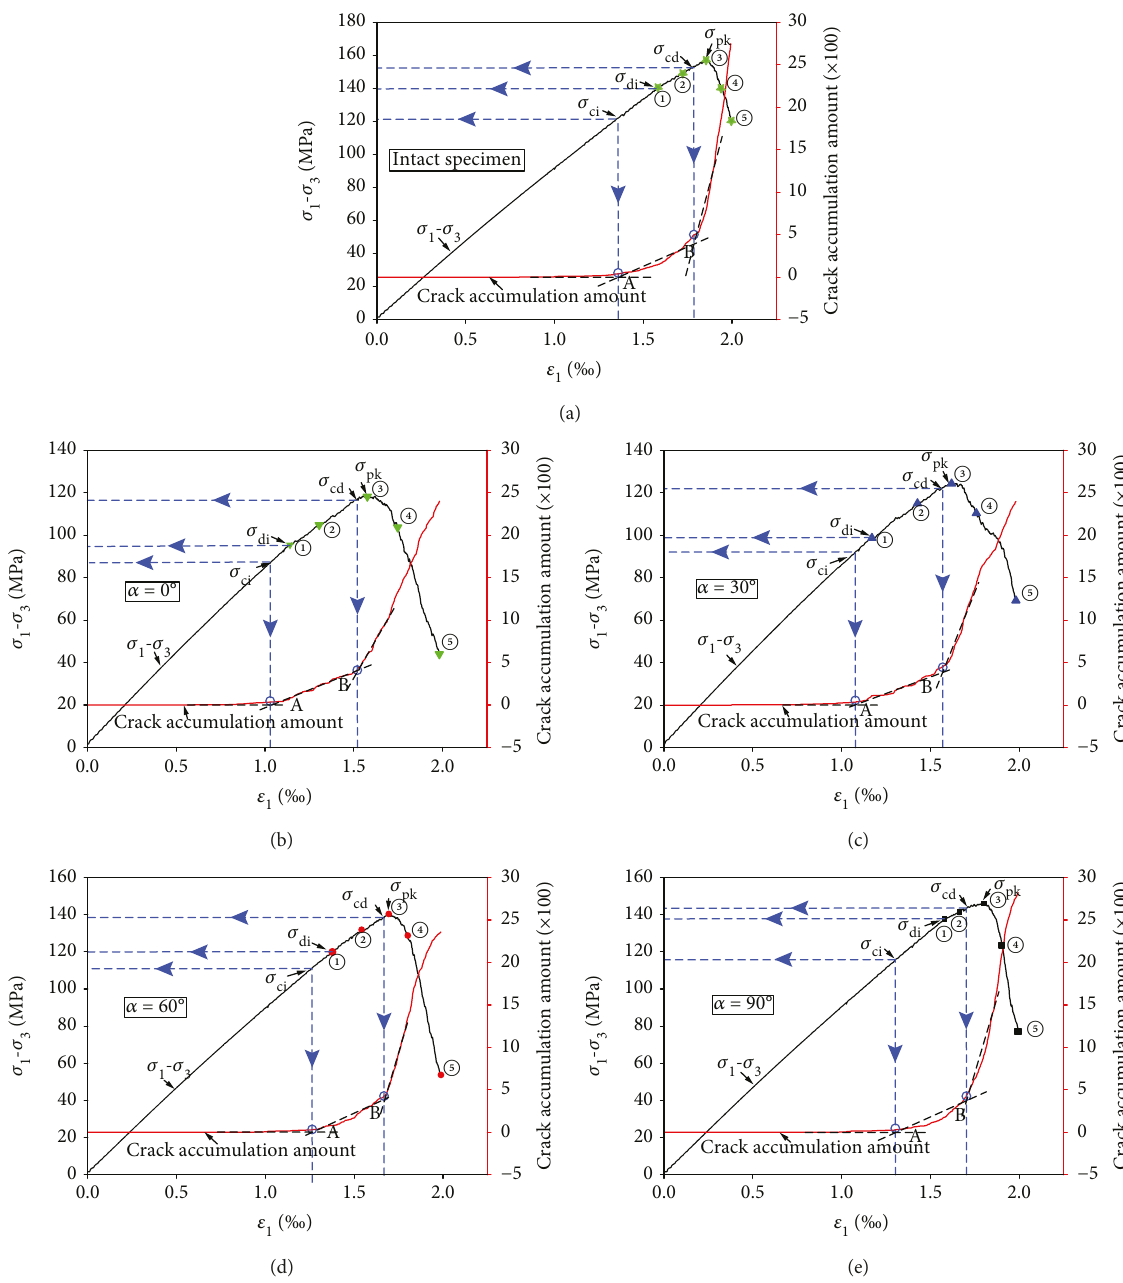
Figure 12: Relations among the deviatoric stress, crack accumulation, and strain of specimens under unloading